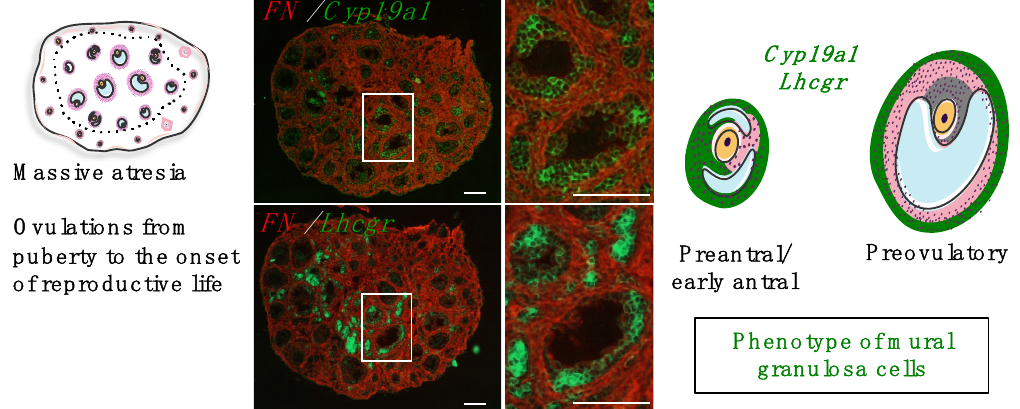
Figure 4. Particular characteristics of the first follicular waves in rodents. The first growing follicles are located in the central region of the ovary, delimited by dotted grey lines. Although most are destined to follicular atresia before puberty, a subset is ovulated at puberty and the very beginning of reproductive life [64,65]. The first follicular waves would be responsible for ovarian endocrine activity throughout prepubertal life [64]. During mini-puberty, immature follicles at the preantral/early antral stage show some functional characteristics of preovulatory follicles, such as Cyp19a1 and Lhcgr expression in granulosa cells [29]. Scale bars: 100 μ m.